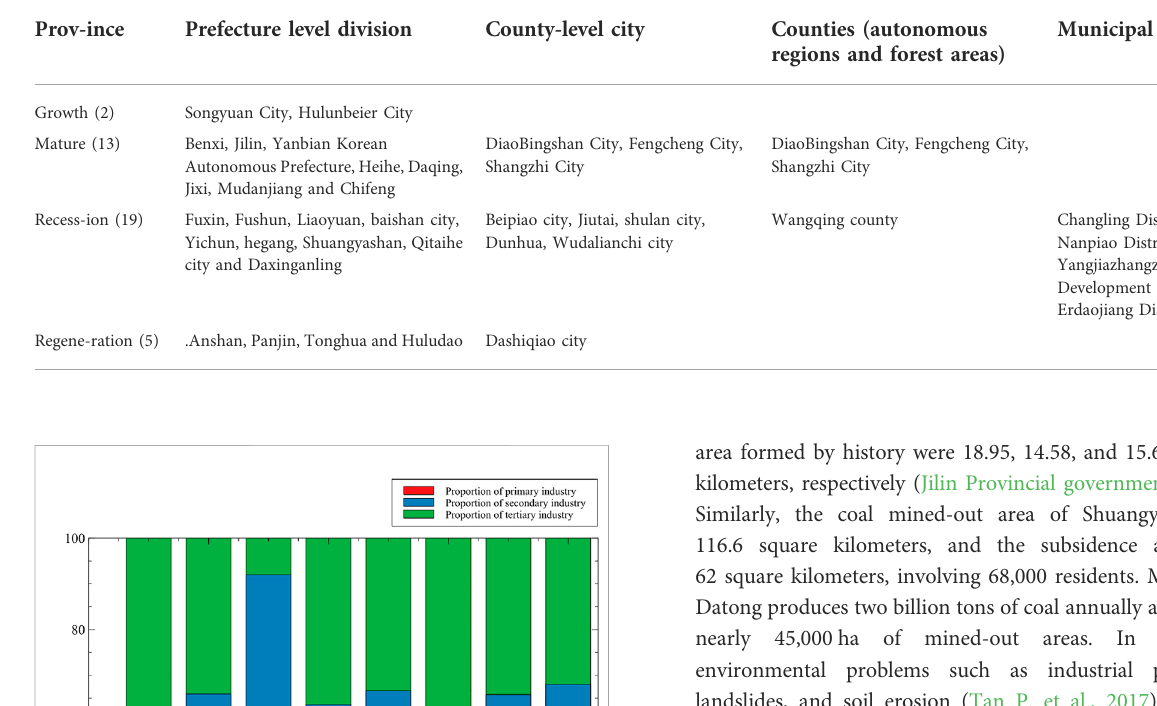
TABLE 2 Classi fi cation of RBCs in northeast China.